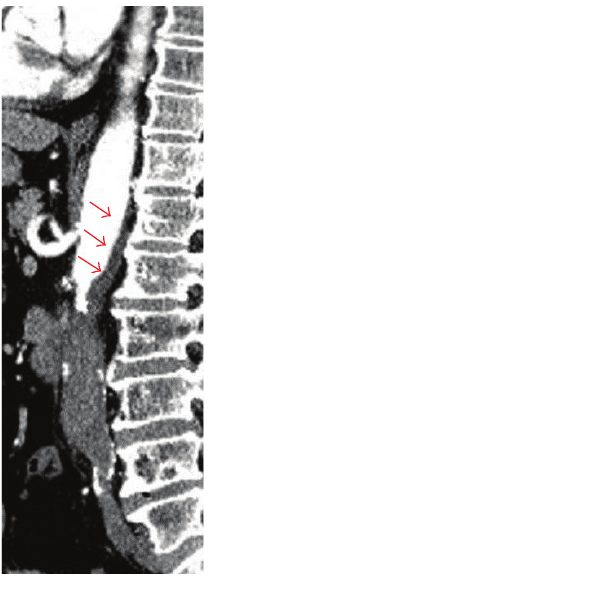
Figure 1: Sagittal view of the acute thrombosis of the abdominal aorta with retrograde partial propagation of the aortic thrombus along the aortic posterior wall up to the level of the patent celiac trunk (red arrows), in addition to severe aortic and iliac calcification.